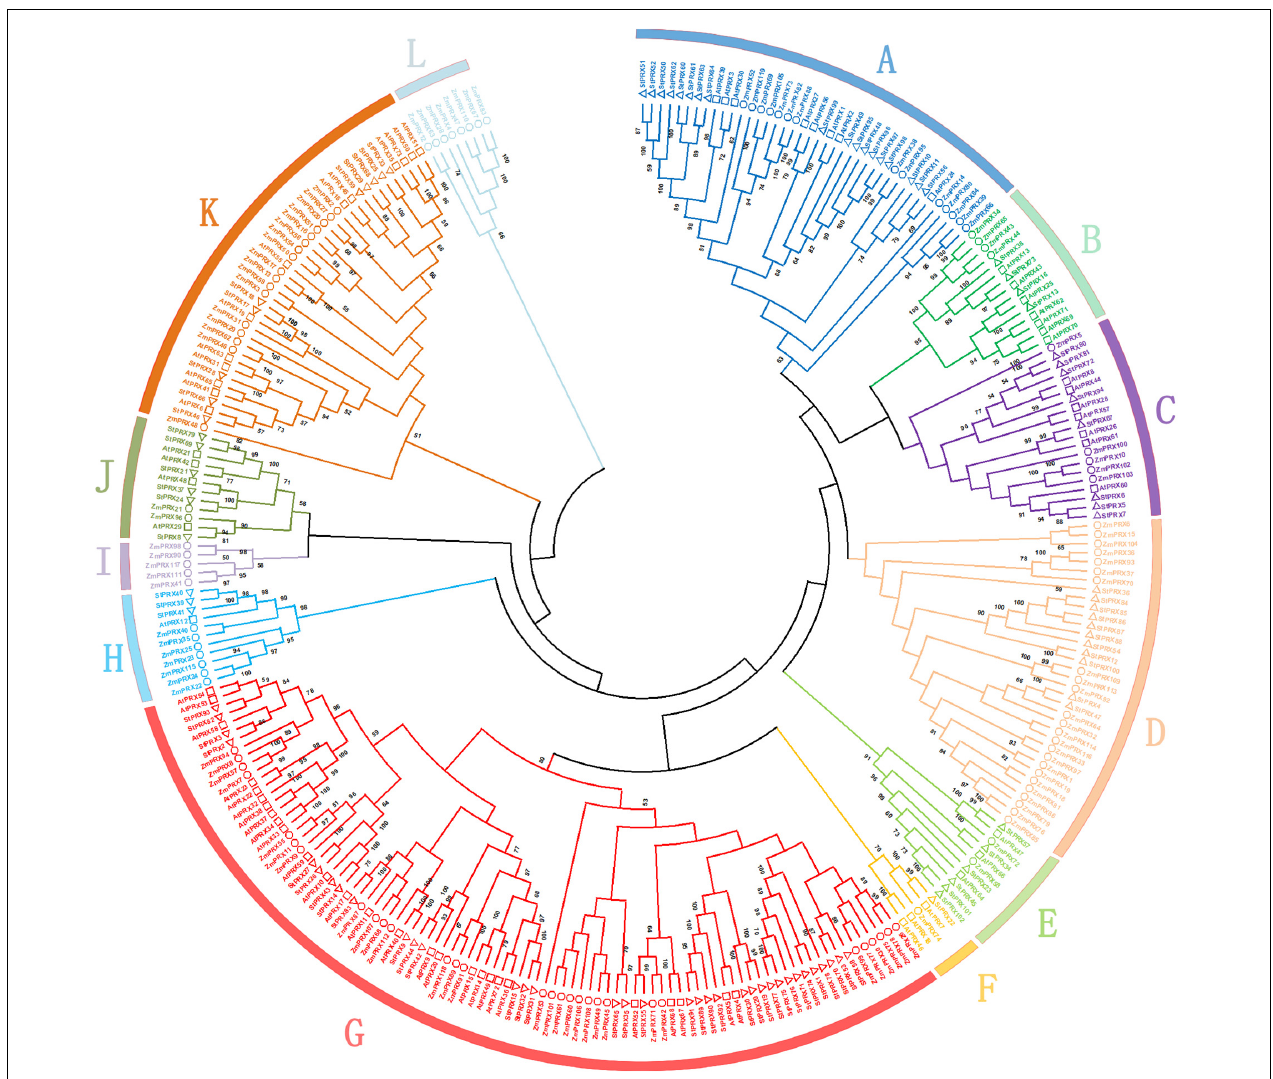
FIGURE 2 | Phylogenetic tree of potato, maize and Arabidopsis PRXs. Each PRX subfamily is shown by a specific color. The phylogenetic tree was constructed by MEGA X with 1000 bootstrap replicates. The circles, squares, and triangles represent maize, Arabidopsis and potato PRX proteins,